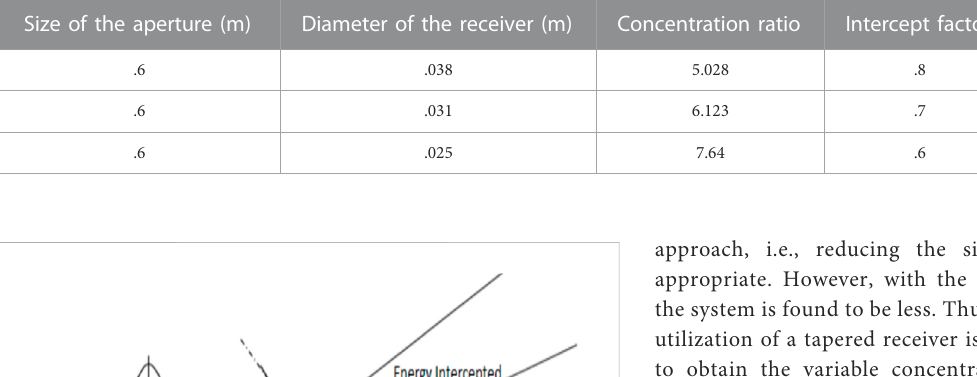
TABLE 2 Relationship between intercept factor and concentration ratio. Size of the aperture (m)